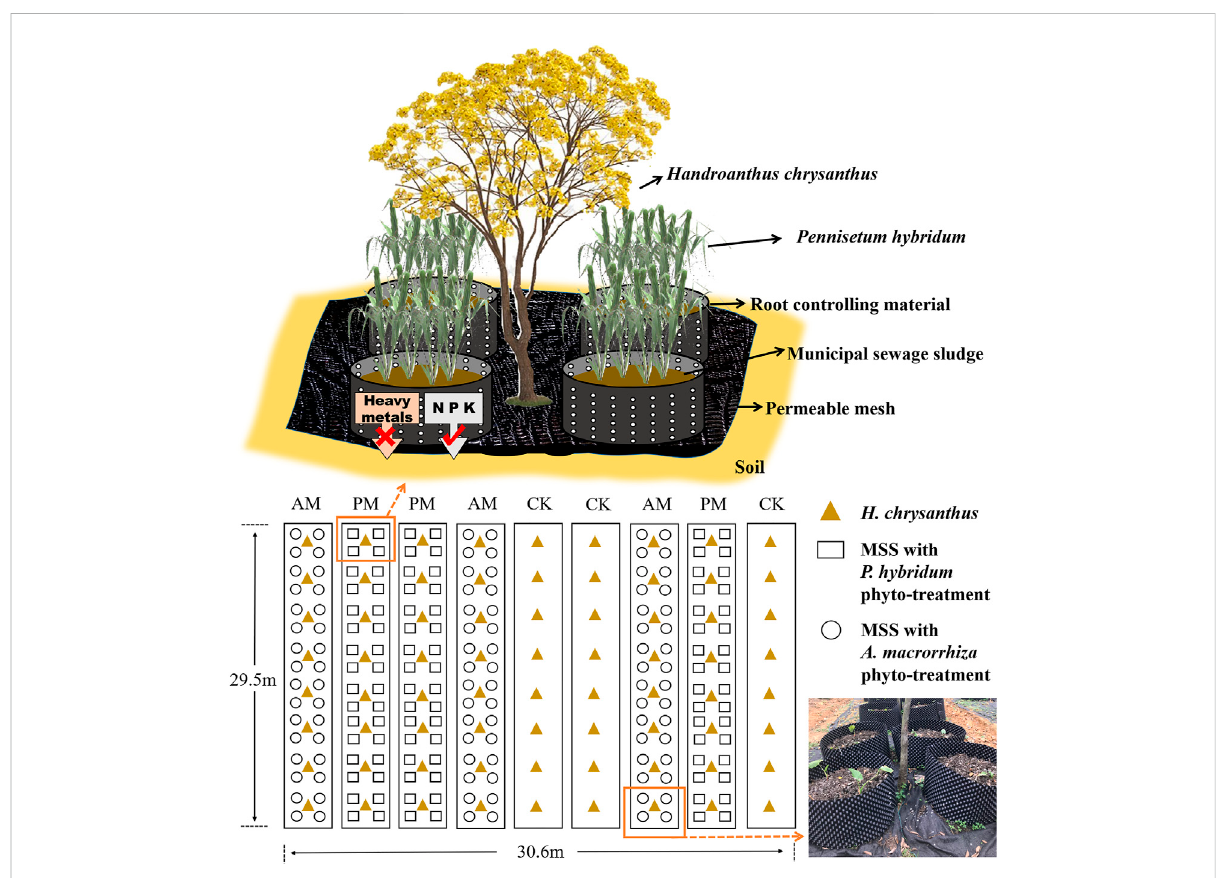
FIGURE 1 Layout of the experimental site and treatments (CK: control without MSS addition; AM: added MSS with A. macrorrhiza phyto-treatment; PM: added MSS with P. hybridum